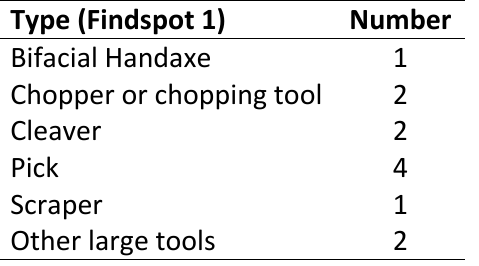
Figure 4. A biface (1), a copping tool (2) and a pick (3). All artifacts made on chert. Table 1. The Lower Palaeolithic lithic